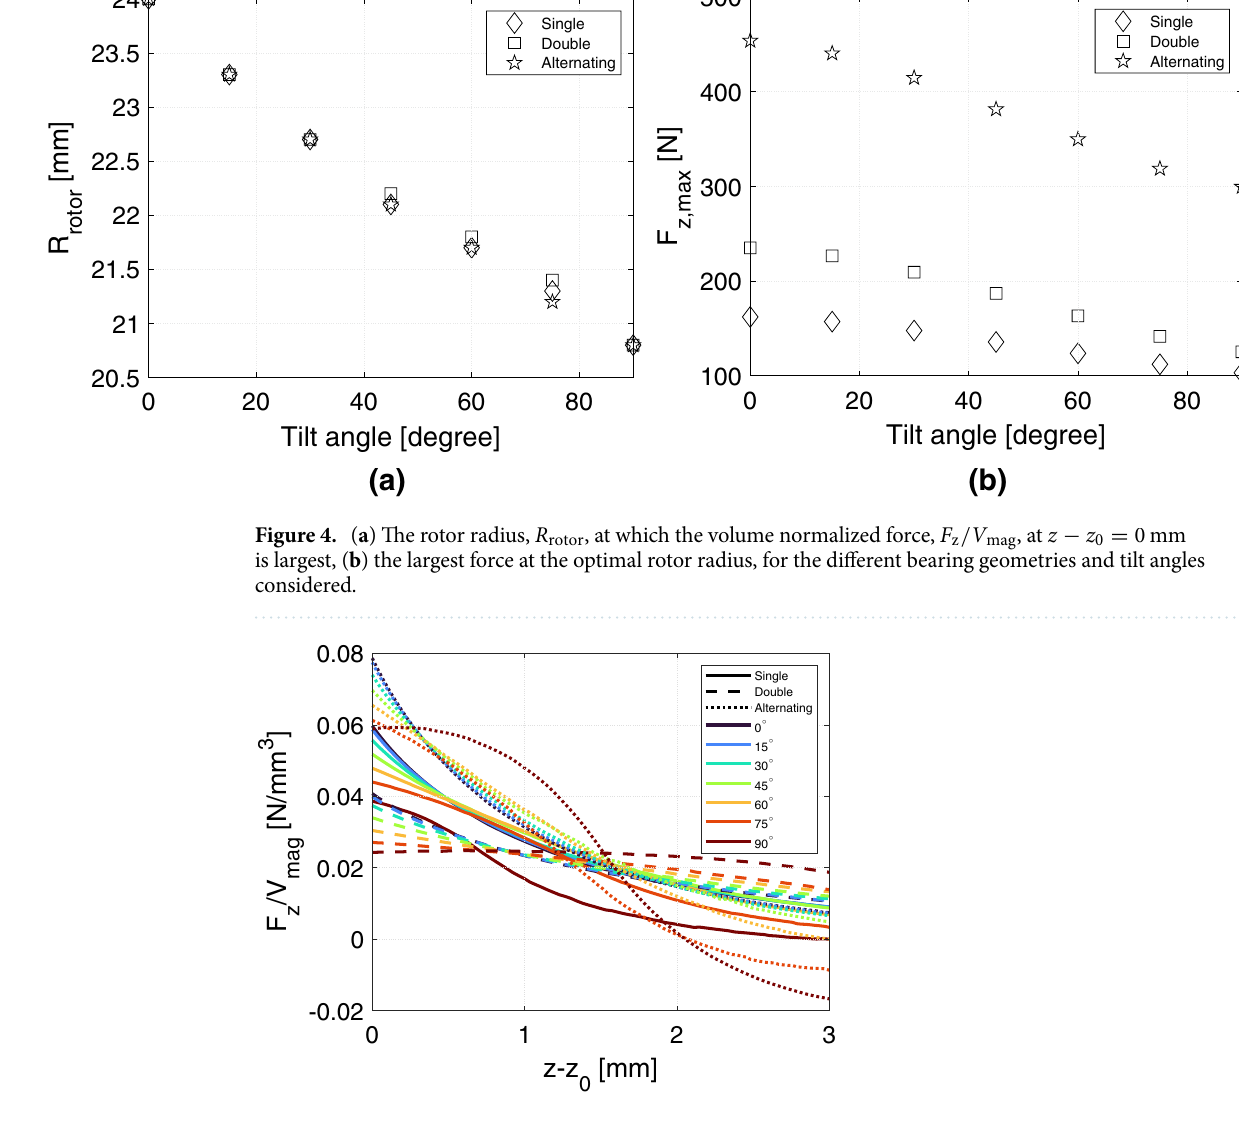
Figure 5. The volume normalized force in the z -direction as function of the relative displacement in the z -direction for the different bearings